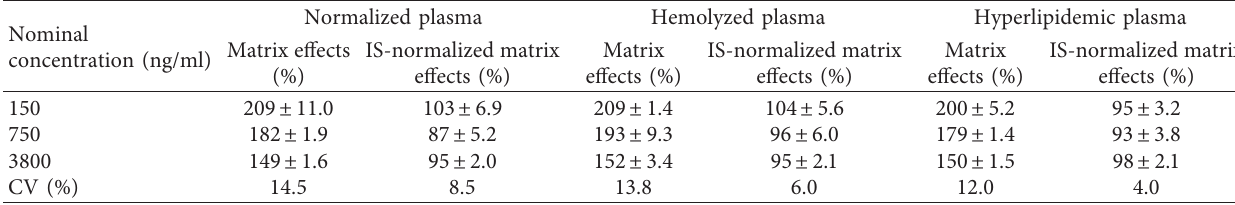
Table 2: Matrix effect of TGC in various plasma matrices.